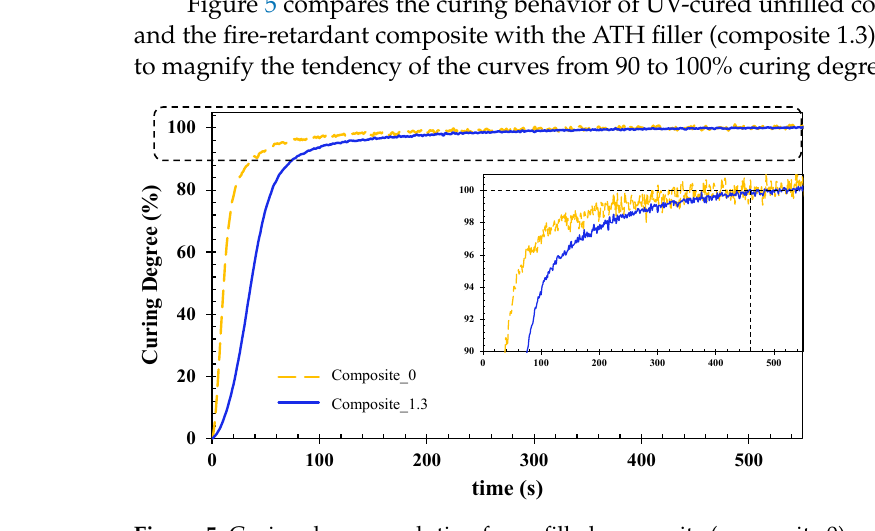
Table 5. Mechanical properties of different composite formulations.